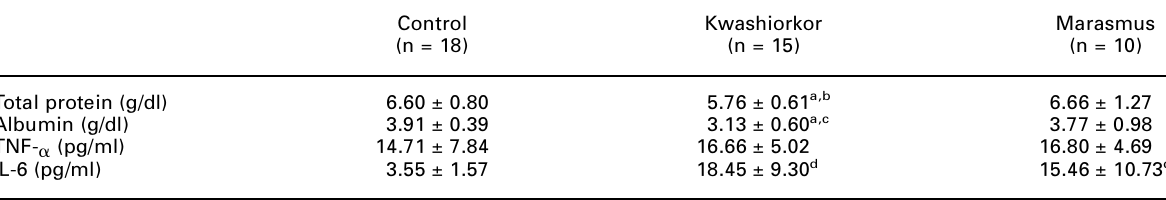
Table 2. Levels of total protein, albumin, TNF- a , and IL-6 of PEM and